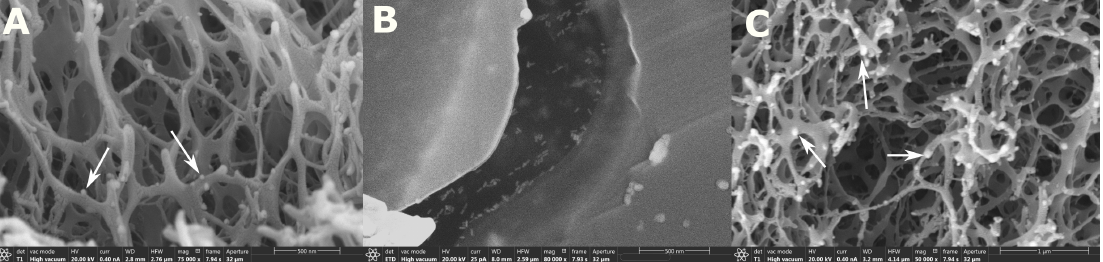
Figure 4. ( A ) SEM image of CPD AAM-AAC-BIS hydrogel with GNRs in BSE mode; ( B ) air-dried GNR solution on carbon tape in SE mode for comparison with SEM images of GNP-hydrogels; ( C ) SEM image of HMDS-dried AAM-AAC-BIS hydrogel with GNP in BSE mode. Note that the scalebar in ( C ) is different from the other images. The white arrows shows the small-sized contrast features observed that could indicate GNR